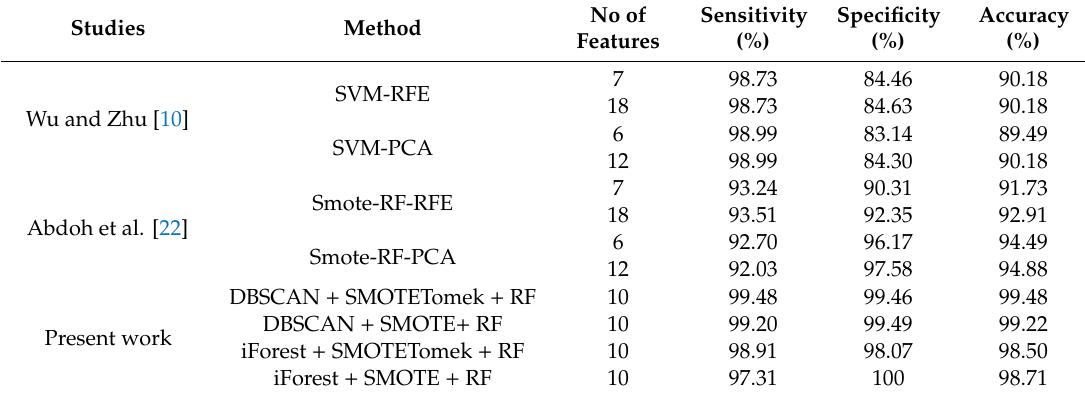
Table 23. Comparison of Schiller test results of CCPM with past studies.